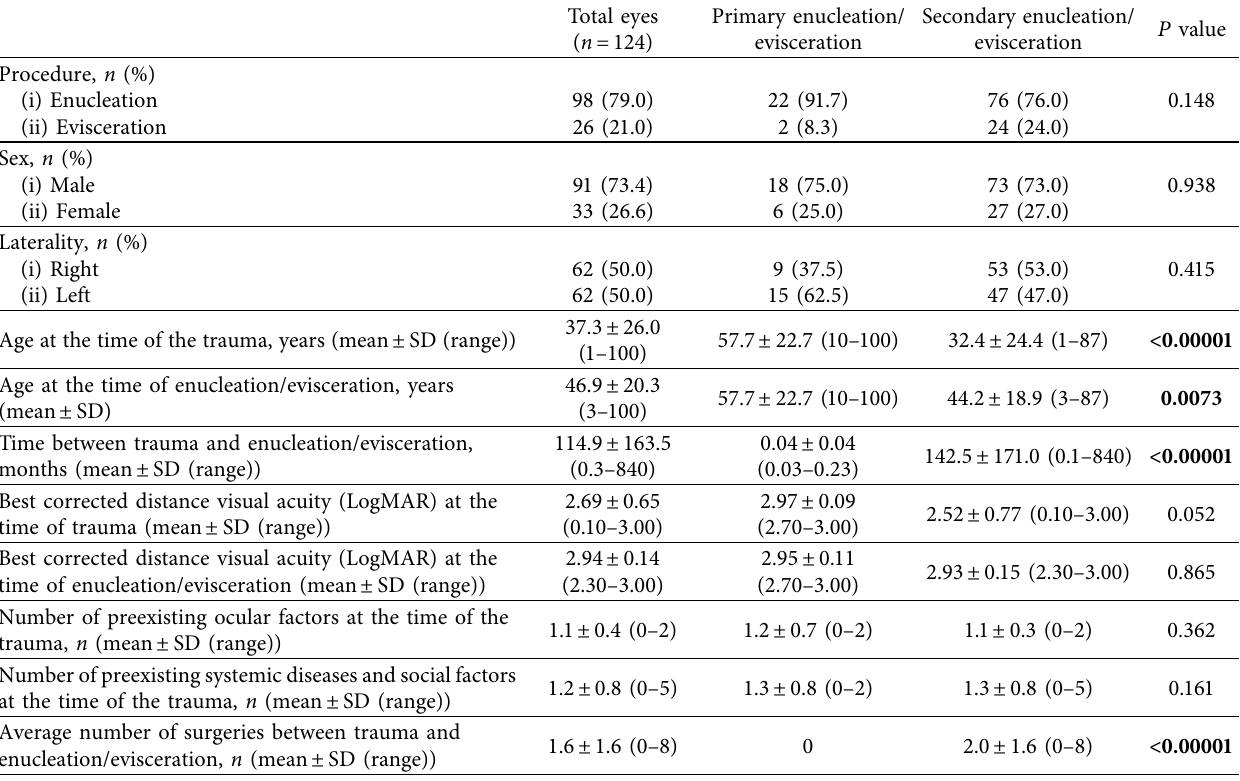
Table 1: Demographic and medical characteristics of patients with enucleation or evisceration due to ocular trauma.